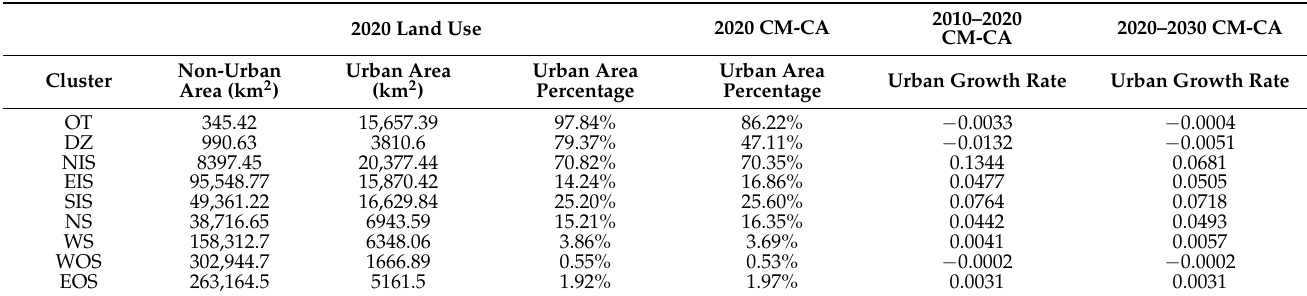
Table 4. Comparison of CM-CA results and real land-use